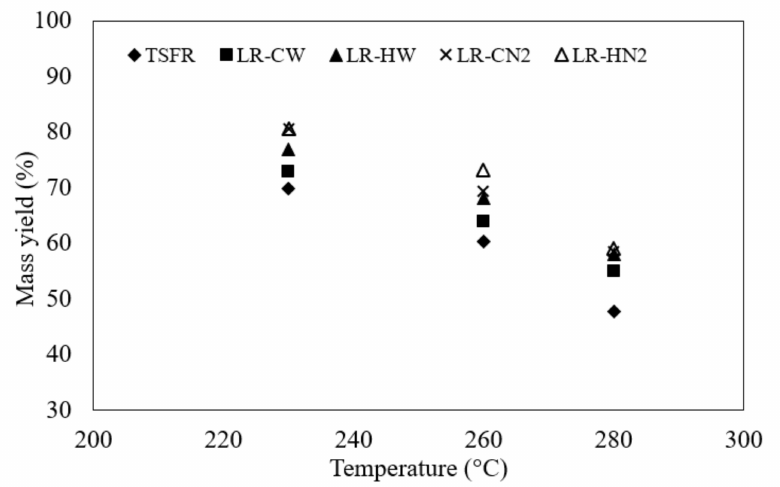
Figure 8. The relationship between mass yield and torrefied